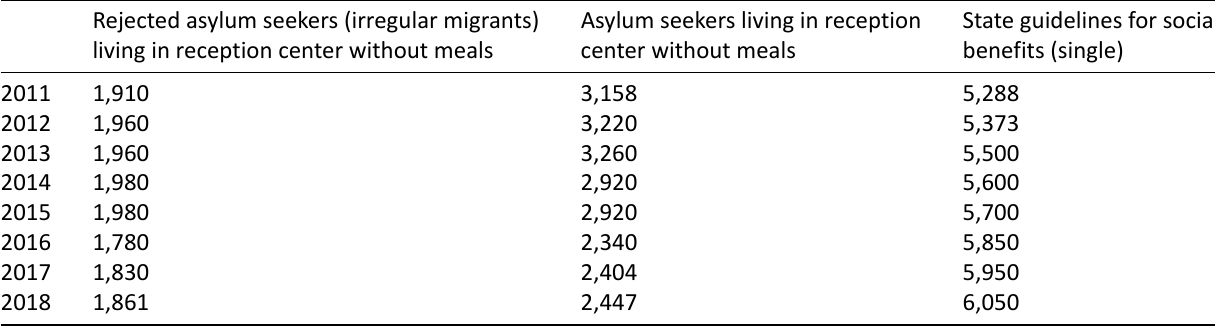
Table 1. Economic benefit rates, in NOK (2011–2018). Rejected asylum seekers (irregular